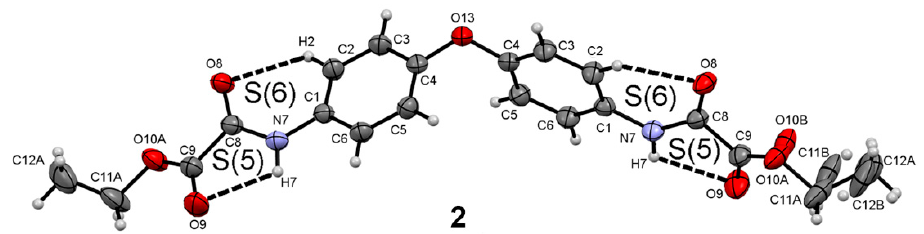
Figure 4. Molecular structure of 2 at 30% of probability level showing the atom numbering scheme and the intramolecular interactions.